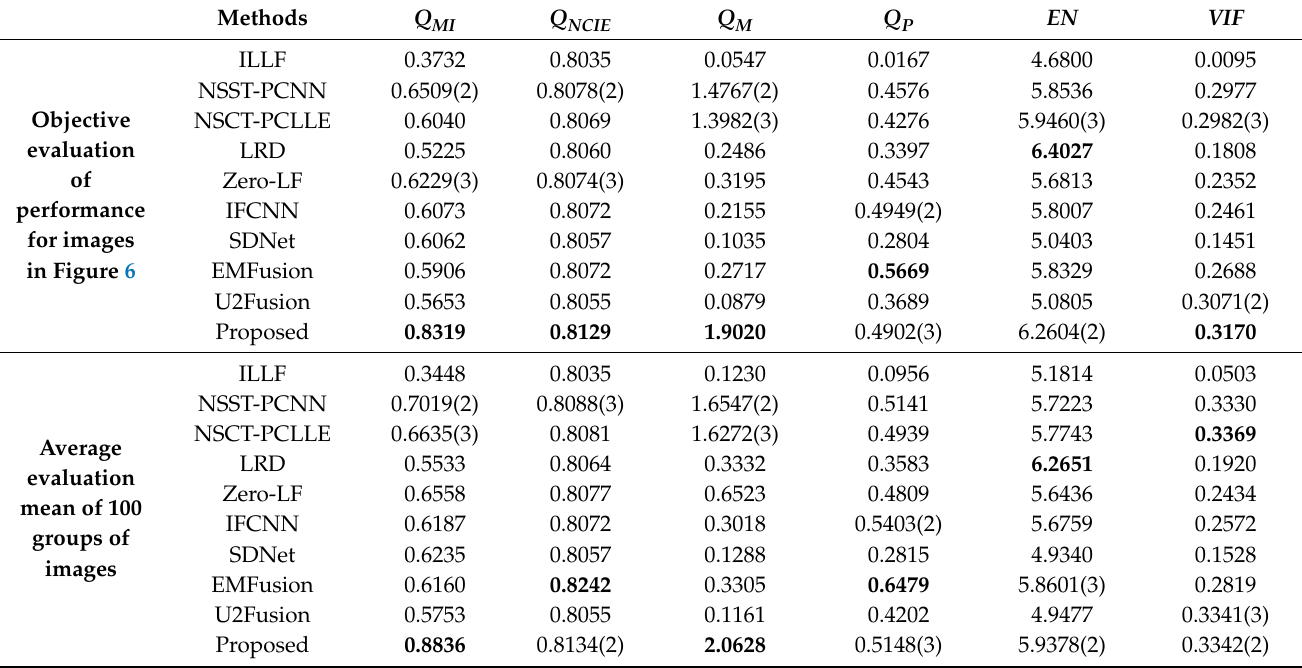
Table 3. Comparison of performance of proposed fusion method with those of nine methods on PET-MRI images; the best results are shown in